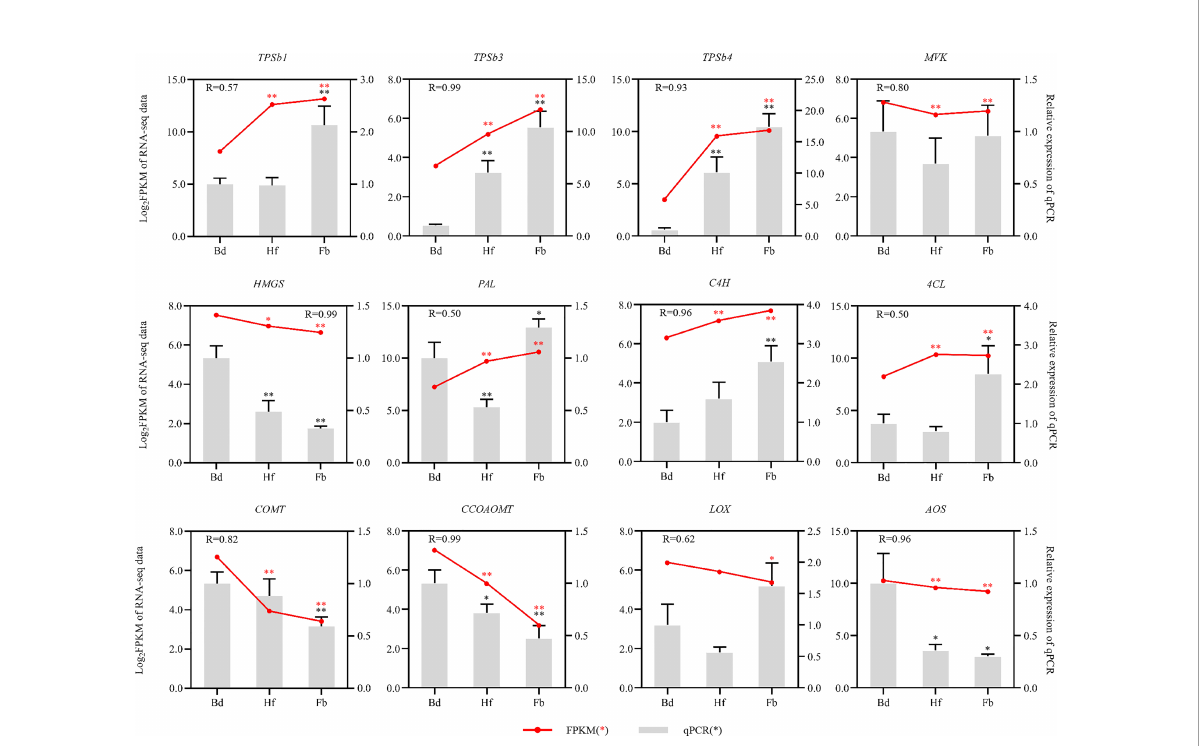
FIGURE 10 Expression patterns of 12 aroma-related genes as veri fi ed by qRT-PCR. Red dots and lines represented the FPKM value from RNA-seq data, and grey rectangle denoted the relative expression levels of genes. The red and black asterisks referred to the statistical signi fi cance of RNA-seq and qRT-PCR, respectively (Bd vs. Hf/Fb). One asterisk: p-value was less than 0.05; Two asterisks: p-value was less than 0.01). COMT , caffeic acid O- methyltransferase; CCOAOMT , caffeoyl-CoA O-methyltransferase; LOX , lipoxygenase; AOS , hydroperoxide dehydratase; Other abbreviations were as shown in Figure